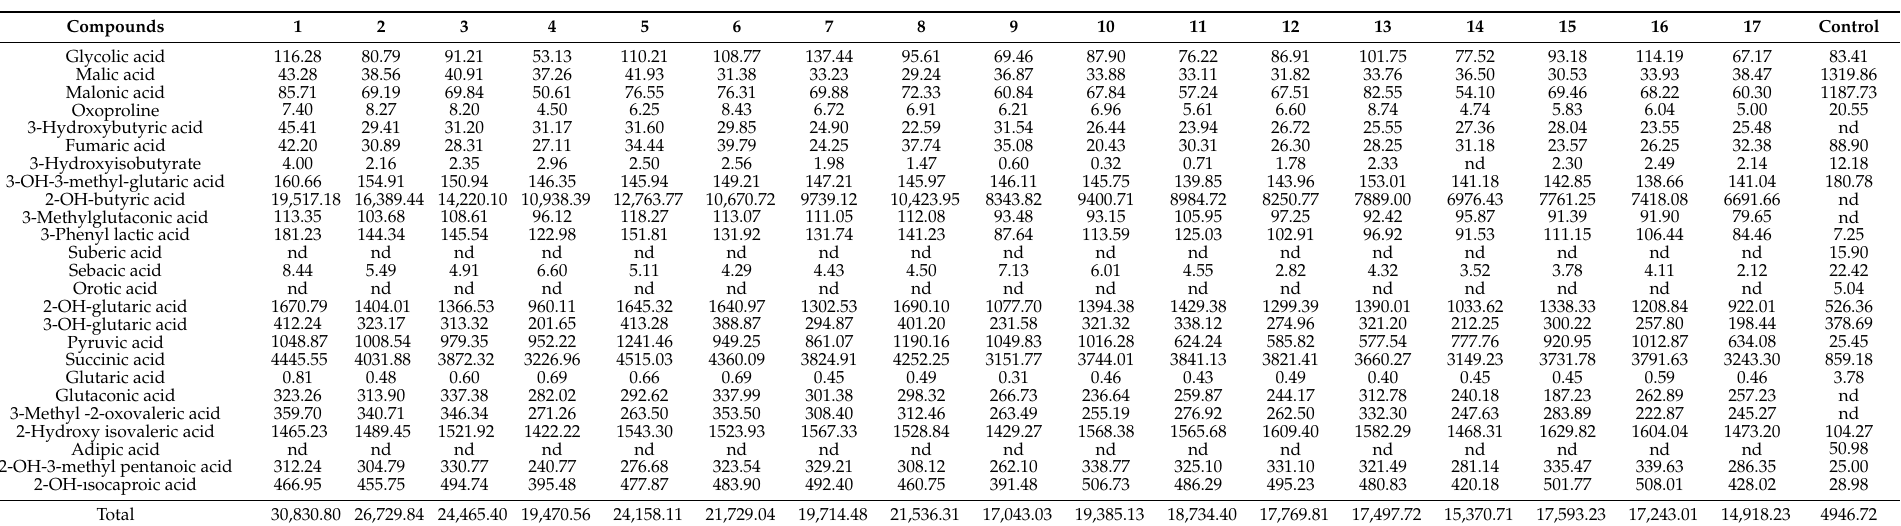
Table 5. Organic acid contents of bee pollen extracts